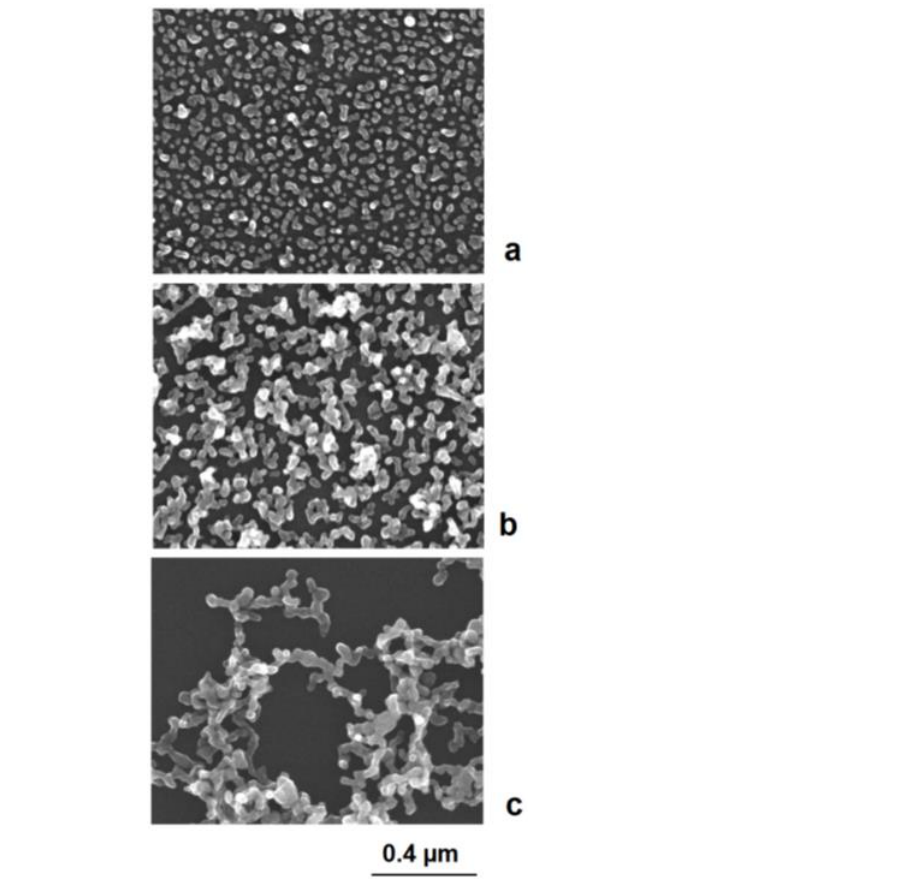
Figure 7. Assembly behavior of charged metal nanoparticles: ( a ) spherical nanoparticles; ( b ) non- spherical metal nanoparticles, for example nanodiscs.